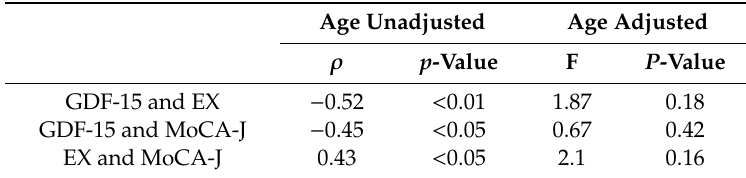
Table 5. Association of EX, MoCA-J, and GDF-15 unadjusted and adjusted by age in chronic obstructive pulmonary disease (COPD). Figure 2. Frequency of sedentary lifestyle, cognitive risk, and MCR among subjects. Data are presented as frequency. P-values show post-hoc analysis between each group. MET: Metabolic equivalent, EX: Exercise (MET × hours), MoCA-J: Japanese version of the Montreal Cognitive Assessment, MCR: Motoric cognitive risk syndrome.